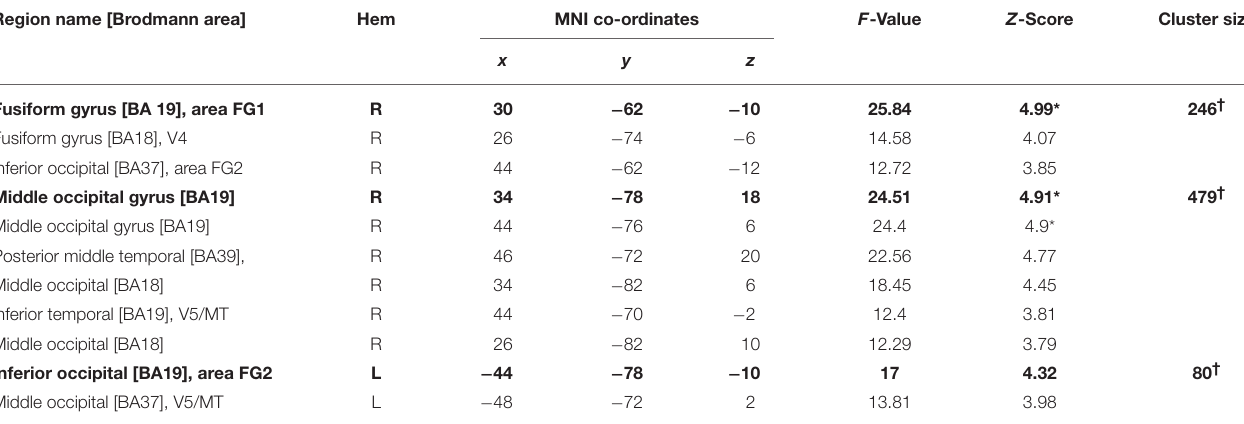
TABLE 2A | Summary of results for the main effect of condition in the control group.